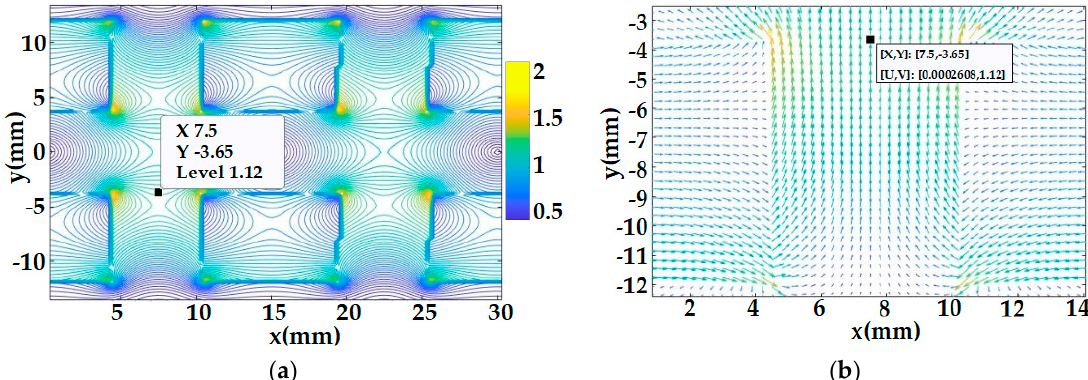
Figure 6. Distribution diagram of air gap magnetic field ( α = 90 ◦ ): ( a ) distribution cloud diagram of |B| and ( b ) localized view of magnetic induction vector B .